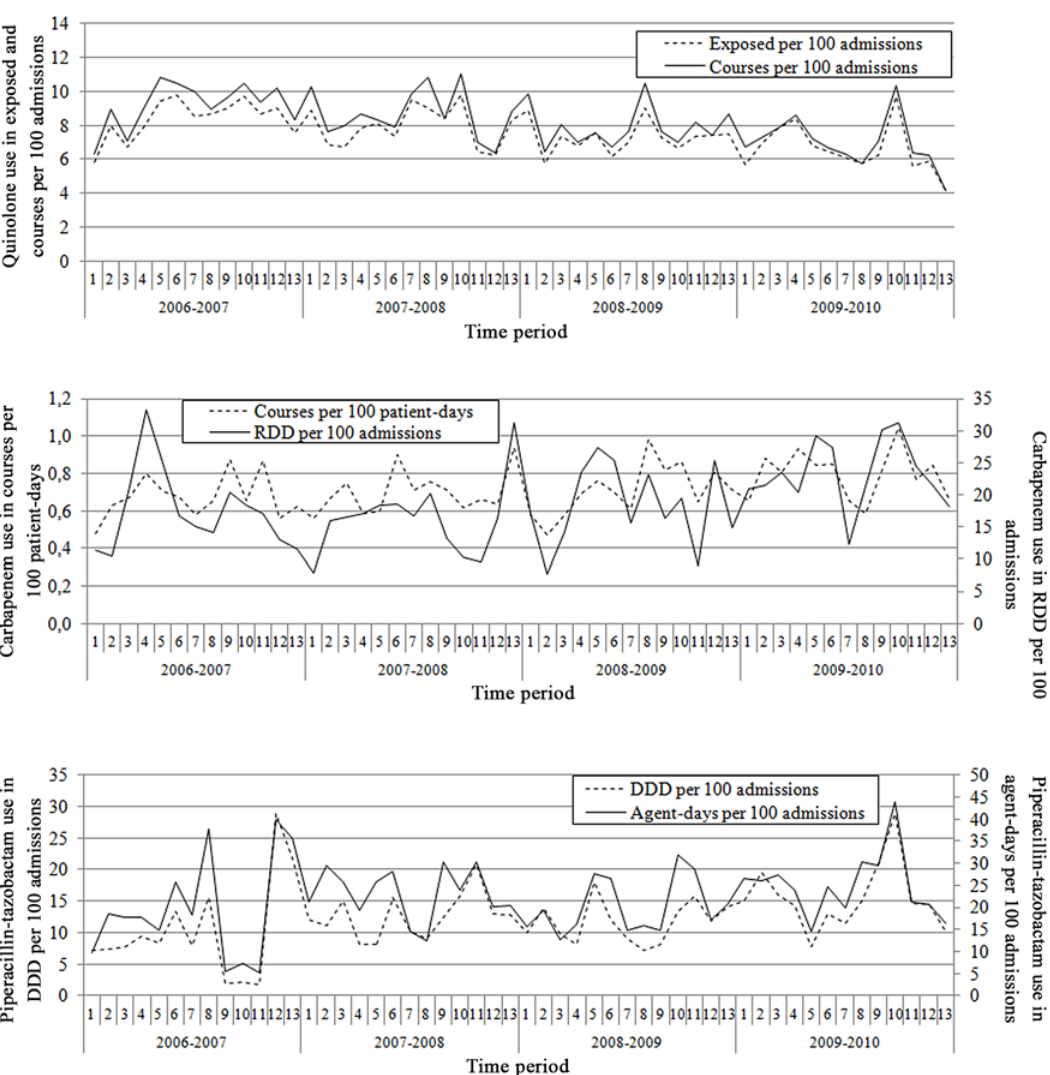
Fig 2. Time series of piperacillin-tazobactam, quinolone and carbapenem use per 4-week period, all ICUs combined. Part A: quinolone use in courses per 100 admissions and exposed per 100 admissions; part B: carbapenem use in courses per 100 patient-days and in RDD per 100 admissions; part C: piperacillin-tazobactam use in DDD per 100 admissions and agent-days per 100